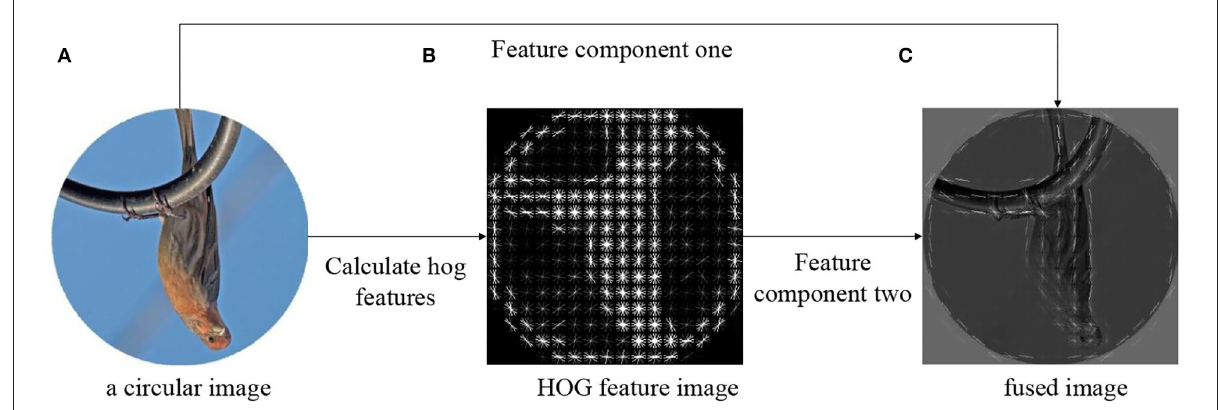
FIGURE2 The fusion process of HOG directional feature and original image. (A) The original image. (B) The directional feature of HOG. (C) The fusion effect according to Equation